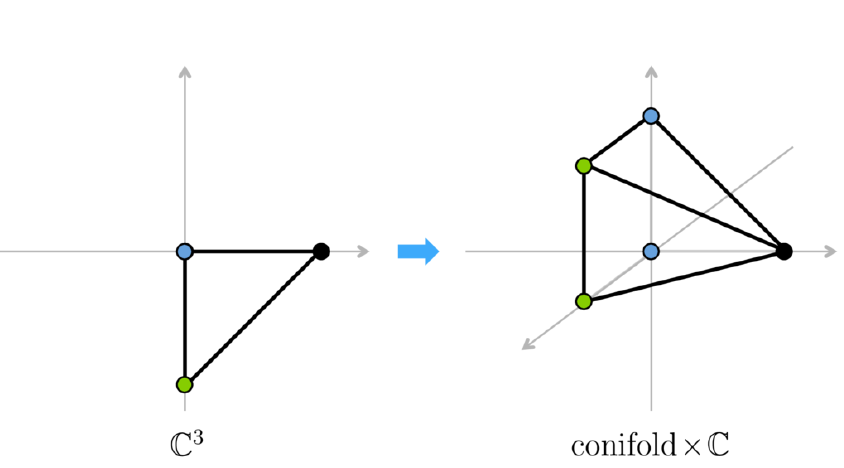
Figure 8. The toric diagram for conifold